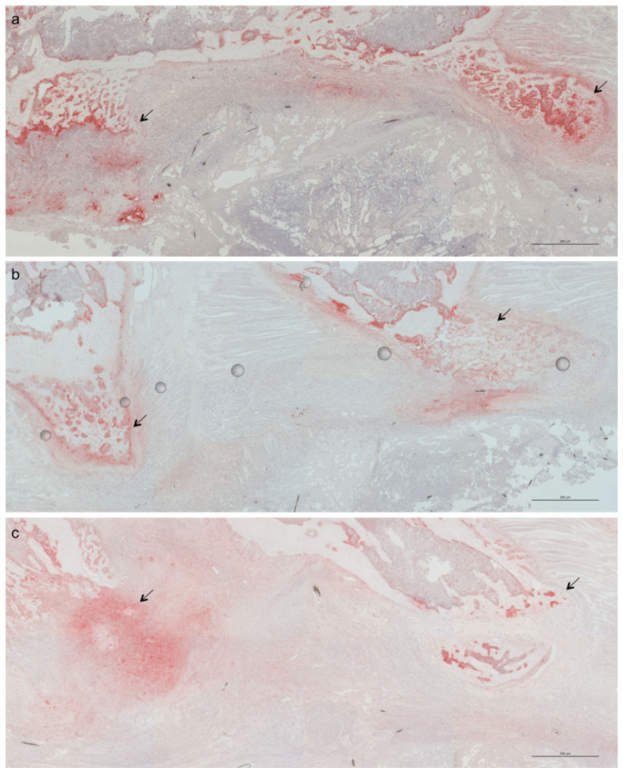
Figure 3. Intermittent Hypoxic Therapy (IHT) reduced osteoclastogenesis. Tartrate-resistant acid phosphatase (TRAP)-stained histological sections of allogenic bone-graft areas after 1 week showed strong TRAP staining of osteoclasts in control mice. Groups included control ( a ), pre IHT ( b ), and post IHT ( c ). Scale bar 500 µ m. Arrows indicate areas of positive TRAP staining.